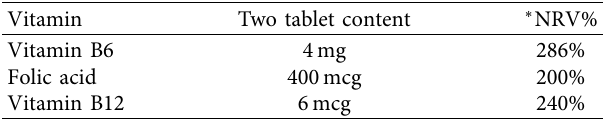
Figure 1: Chemical structure and derivation of the molecules with vitamin B6 action [20]. Table 1: Vitamin content of 2 tablets ( ^ dose taken by the mother of the over-the counter supplement during pregnancy); ∗ NRV � Nu- tritional Reference